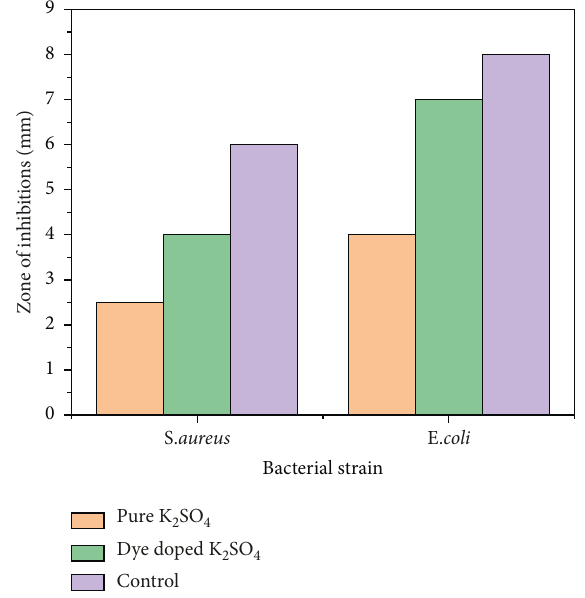
Figure 12: Antibacterial activity of the methyl orange dye-doped K 2 SO 4 single crystal.